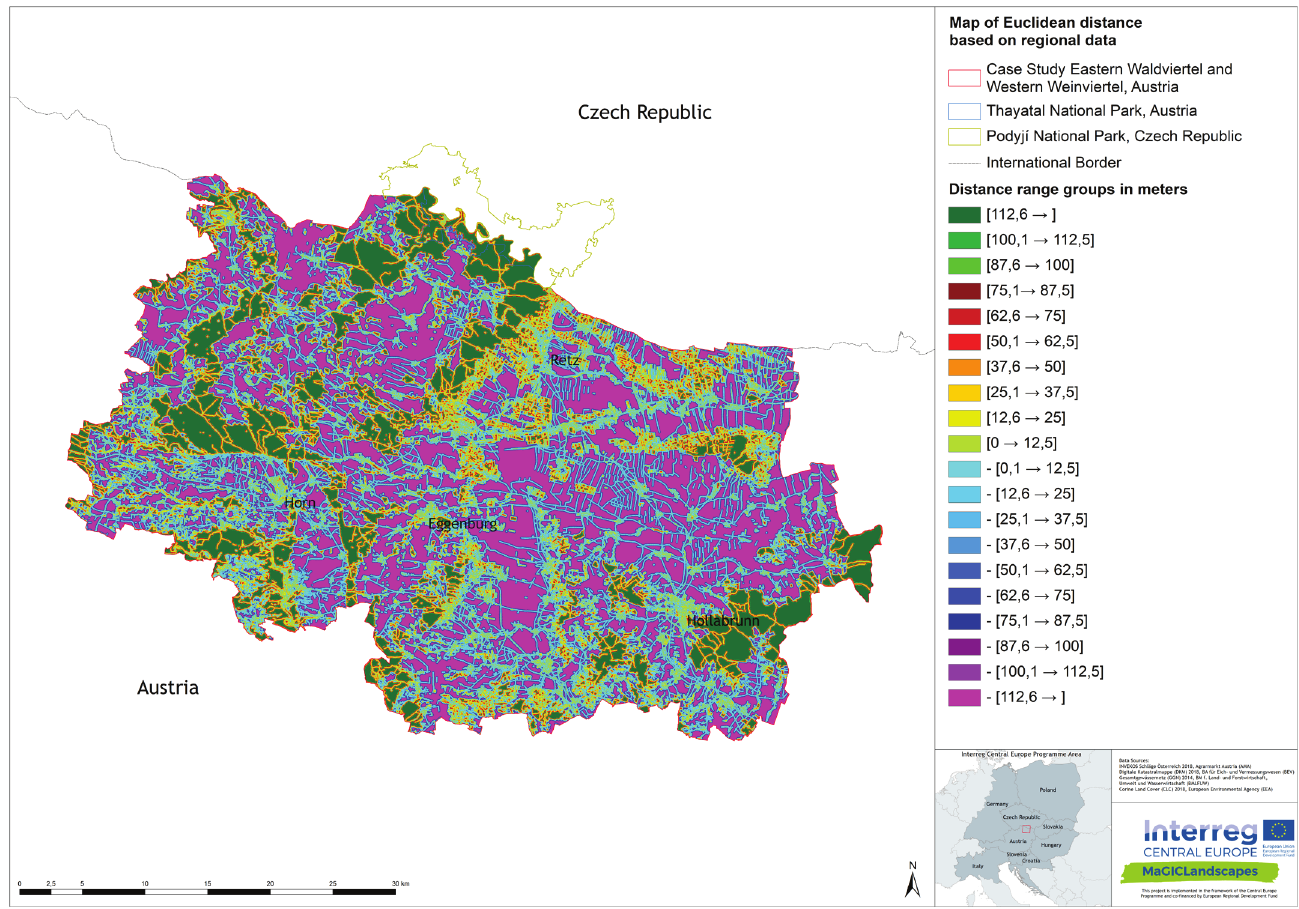
Figure 7. Map of Euclidean distance of GI in the Austrian case study based on regionalised